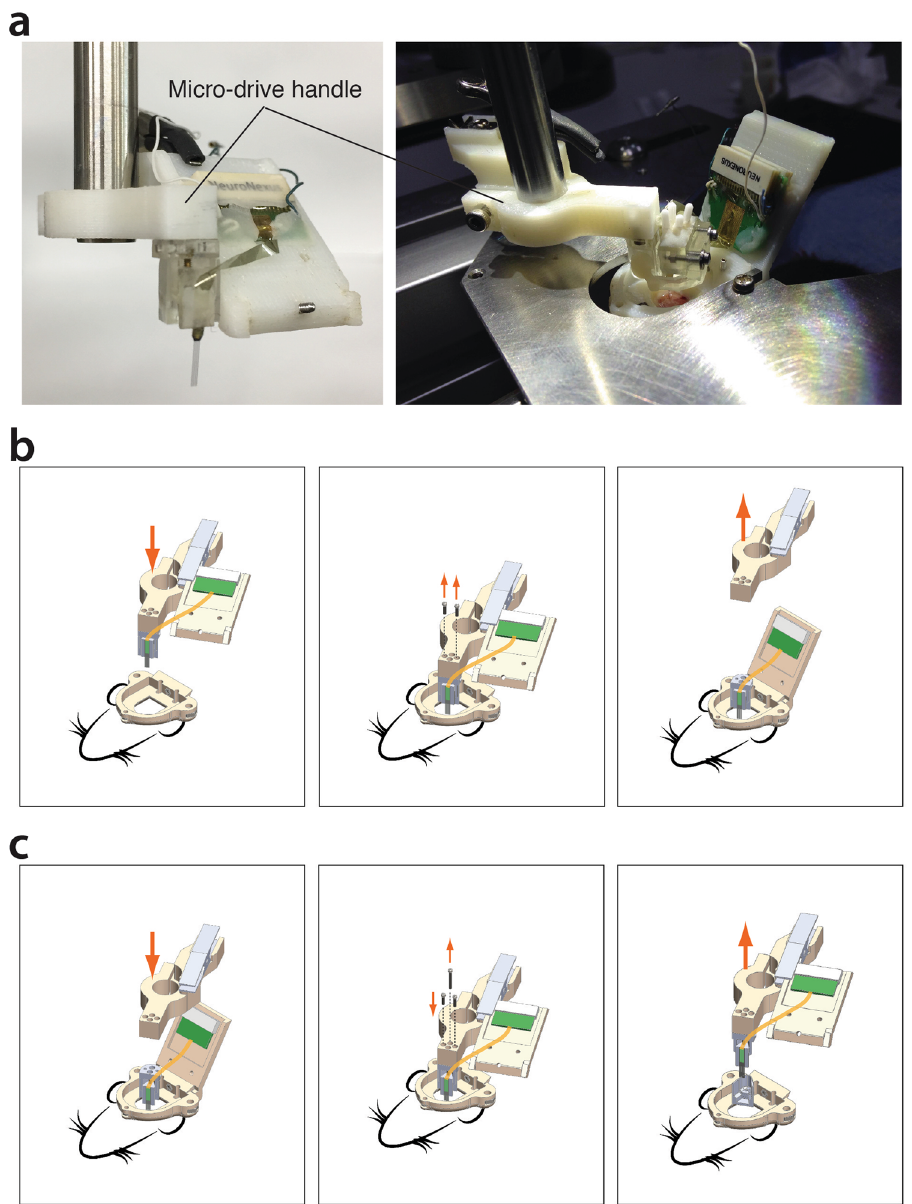
Figure 4. Procedure to implant and recover the electrodes. ( a ) Silicon probe (left) and optoelectronic probe (right) packages ready for implantation. ( b) Following the probe implant (left) and cementation of the micro- drive to the head-plate, the handle is detached by unscrewing the side screws (centered) and retracted (right). ( c ) To recover the probe after the experiment, the handle is fixed to the micro-drive (center), the back screw holding the micro-drive body to the shell is removed (center), and the electrode/micro-drive assembly is retracted